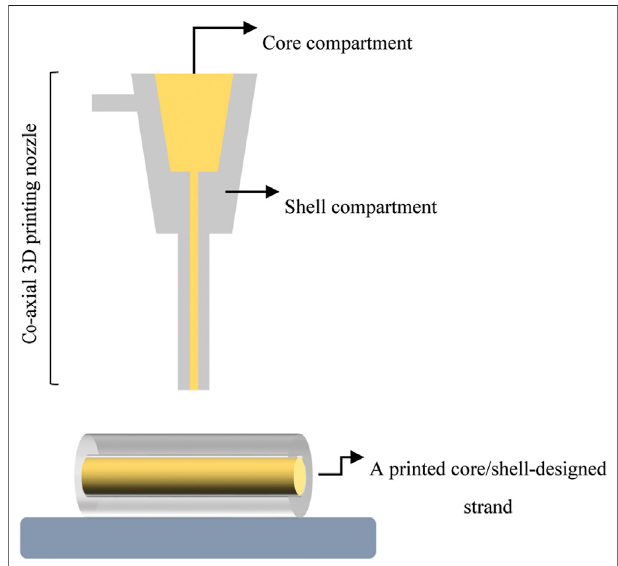
FIGURE 5 | A schematic illustrating core/shell designed strand fabricated with a co-axial 3D printing